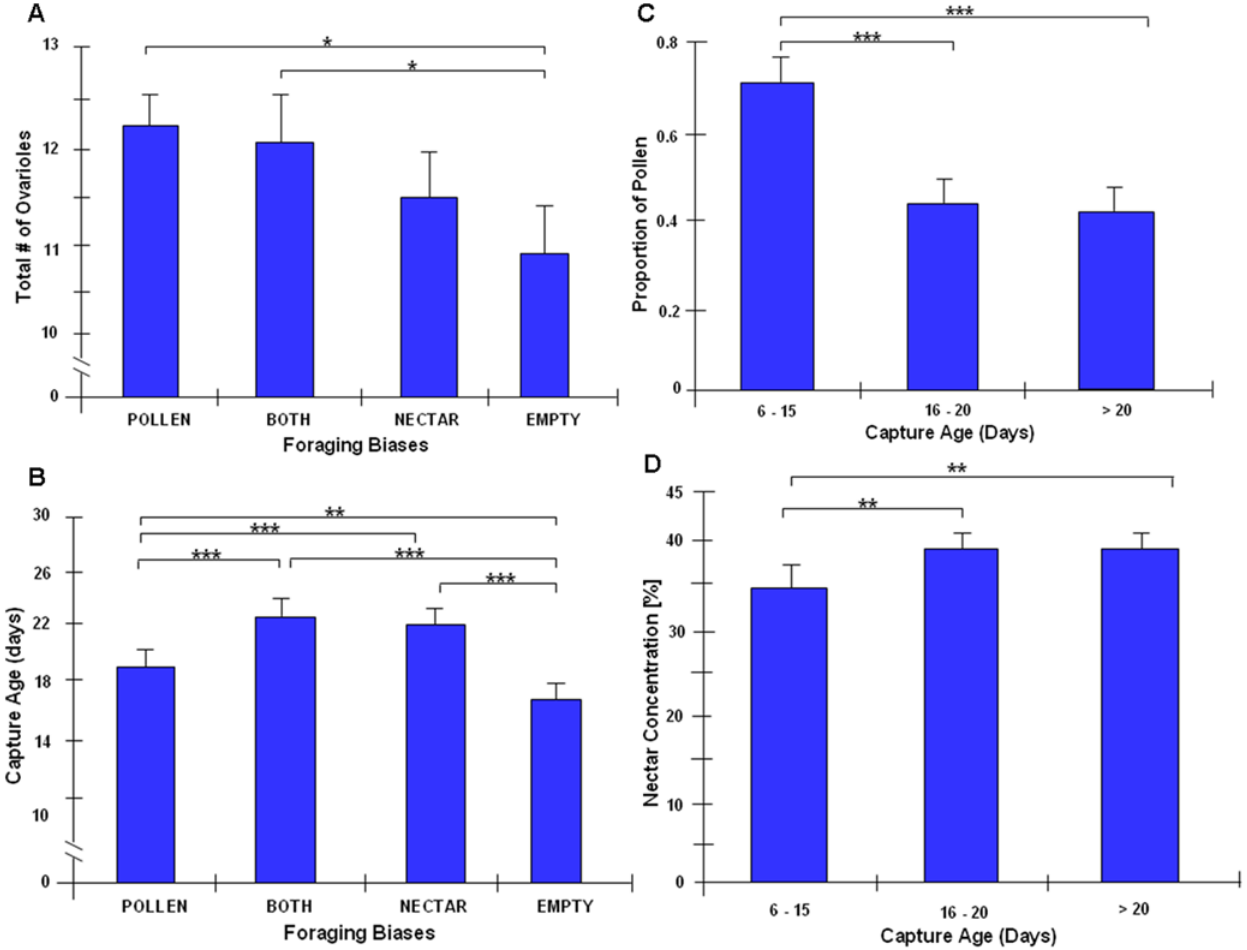
Figure 2. Associations between ovary size and behavior. A: Total ovariole number (mean 6 s.e.m) in different foraging behavior groups derived from a backcross of high and low pollen-hoarding strains (BOTH=pollen and nectar; EMPTY=no measurable pollen and nectar; POLLEN=pollen and NECTAR=nectar). B: The capture age (first foraging age) (mean 6 s.e.m) in different behavior groups. C, D: The pollen load proportion and nectar load concentration of the same bees divided by different capture age groups. *, , 0.05; **, , 0.01; ***, , 0.001.